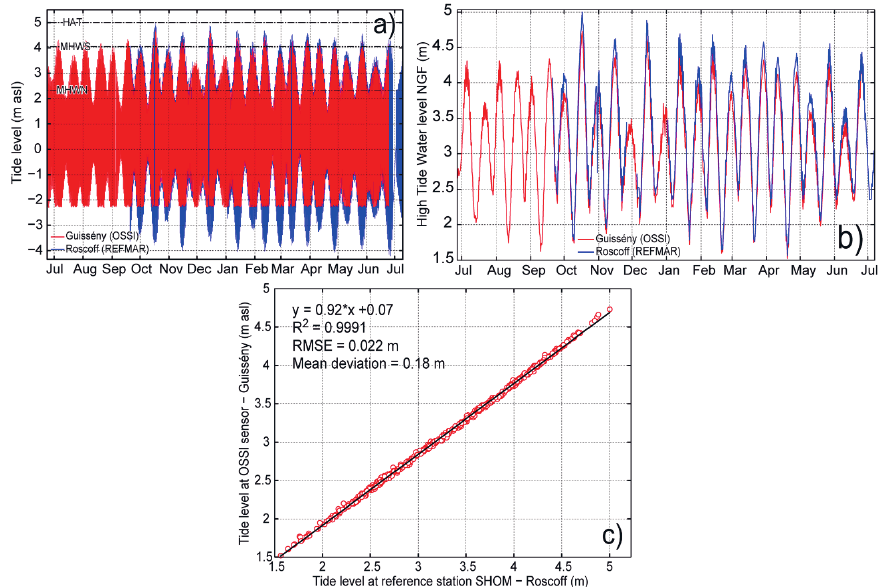
Figure 5. Offshore (WW3) and shallow (OSSI) wave heights ( a ) and periods ( b ) obtained between July 2012 and June 2013. Correlations between offshore and shallow wave heights ( c ) and periods ( d ).